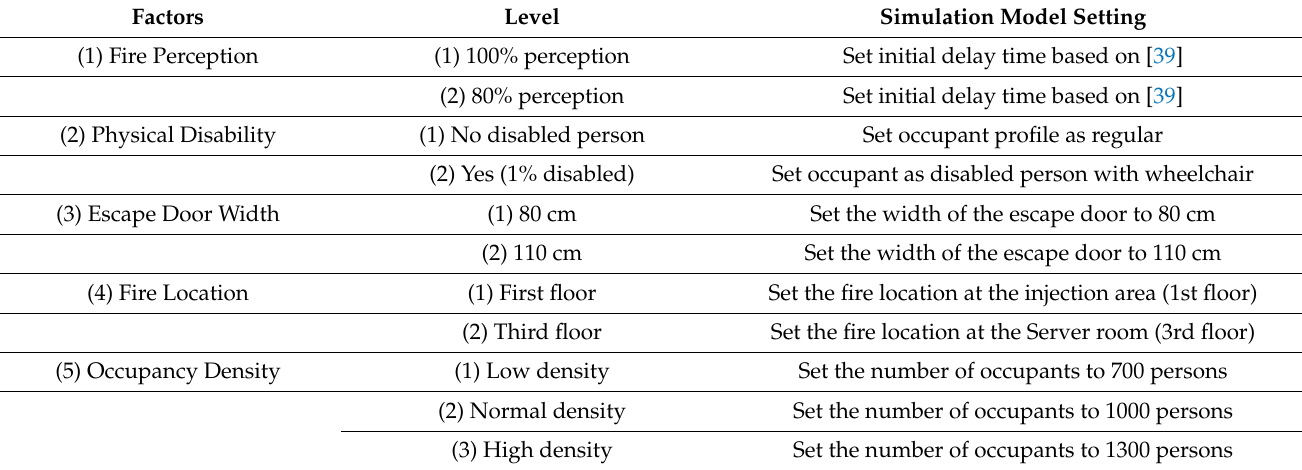
Table 2. Factors and levels for the experiment.